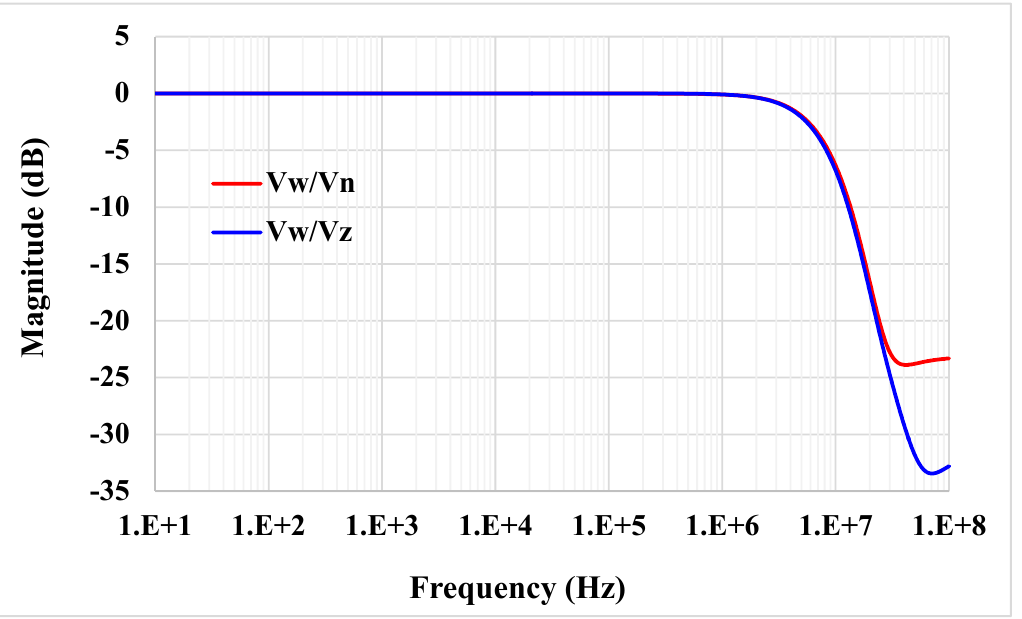
Figure 7. The frequency responses of | V w / V n | and | V w / V z |.